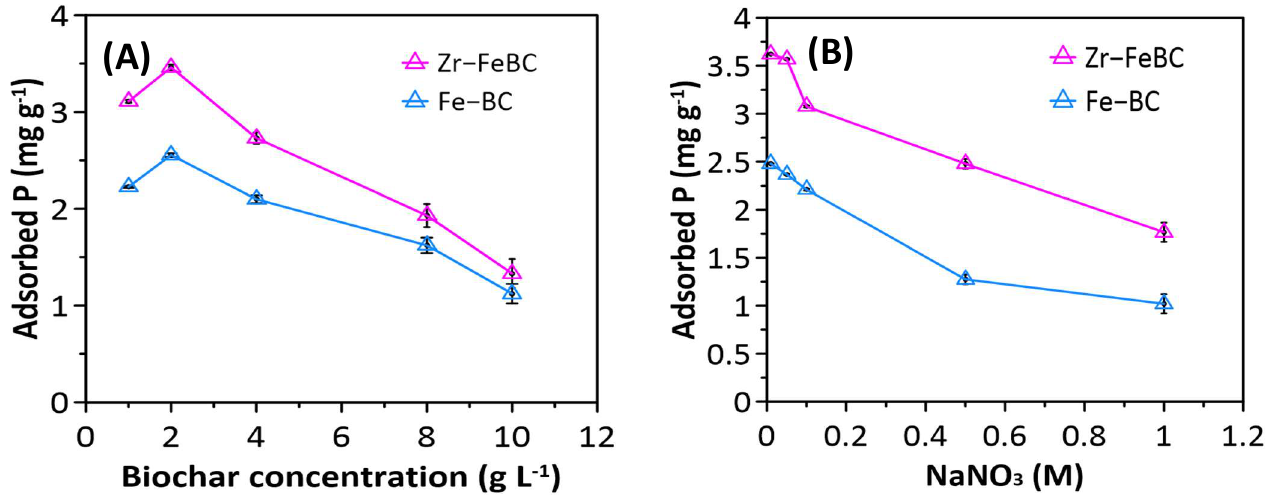
Figure 4. Effect of biochar concentration ( A ) (initial P concentration was 20 mg L –1 and biochar concentration was 1–10 g L –1 ), and effect of ionic strength ( B ) on P adsorption (initial P concentration was 20 mg L –1 , biochar concentration was 2.0 g L –1 , at 22 ± 0.5 °C).